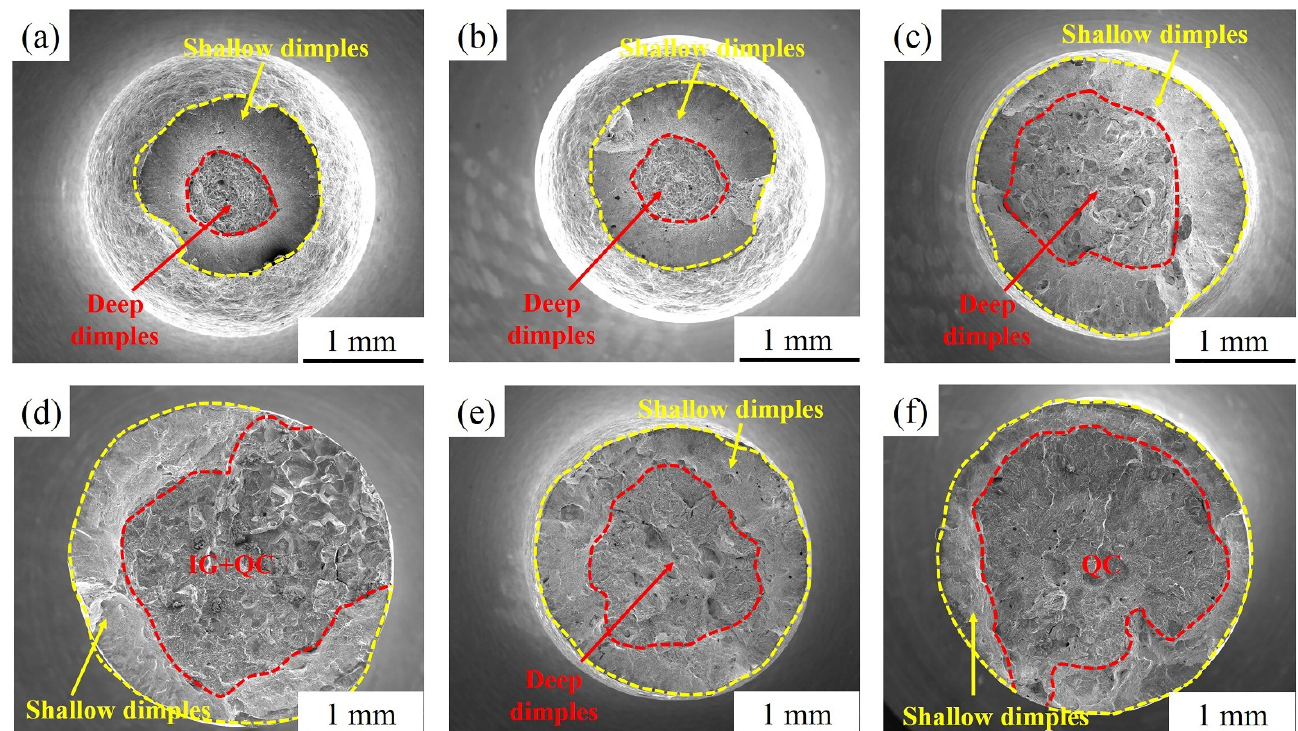
Figure 13. Fracture morphology of the specimens aged at 600 °C for various holding times after SSRTs in air and 3.5 wt.% NaCl solution: ( a ) air, 600A-0.5; ( b ) solution, 600A-0.5; ( c ) air, 600A-4; ( d ) solution, 600A-4; ( e ) air, 600A-80; and ( f ) solution, 600A-80.